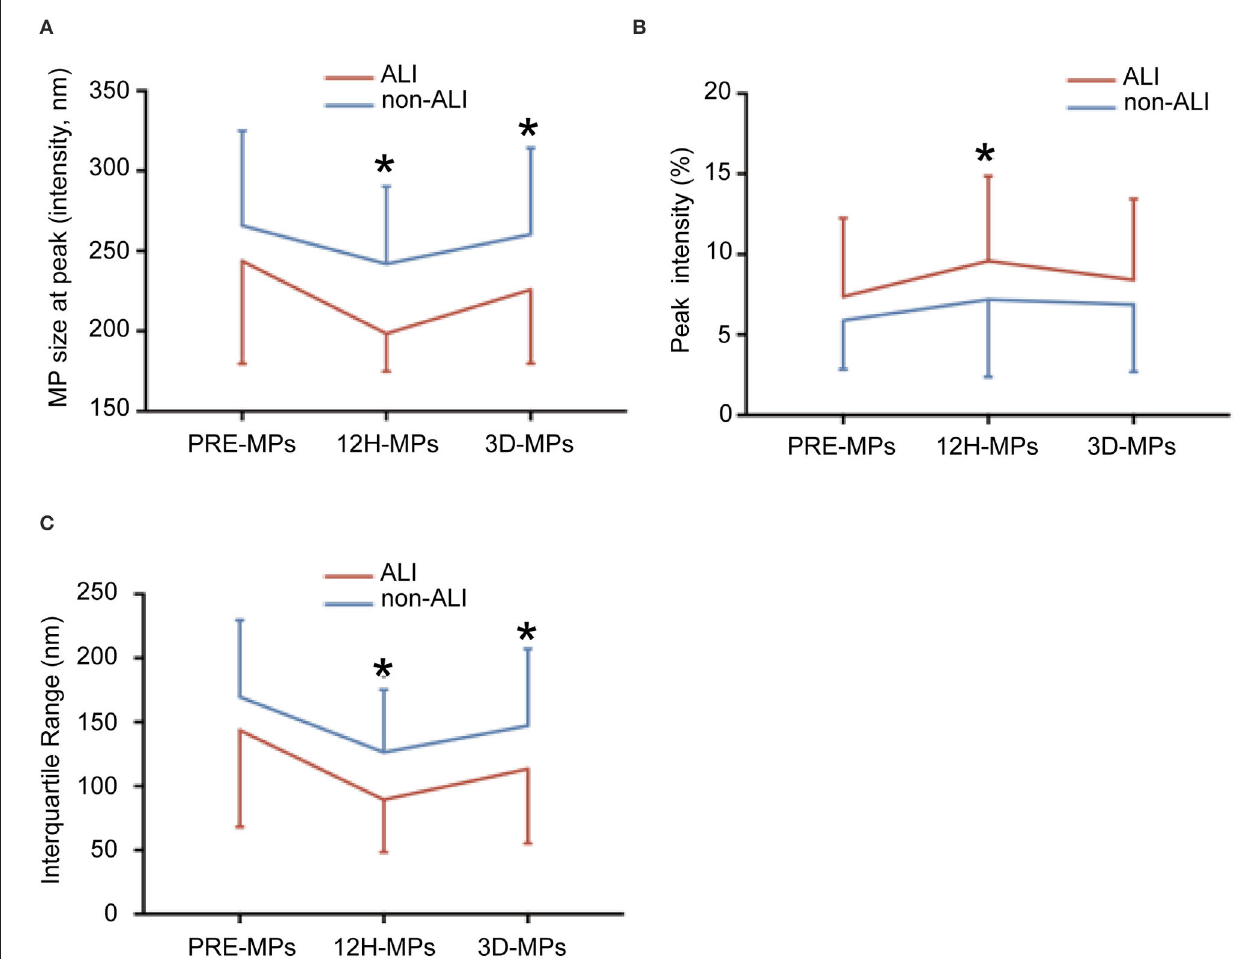
FIGURE 5 | The size distribution of microparticles (MPs) at different times between ALI and non-ALI groups. (A) The MPs size at peak between ALI and non-ALI groups. (B) The IQR between ALI and non-ALI groups. (C) The peak intensity between ALI and non-ALI groups. *, vs. ALI group at the same time point, P < 0.05. PRE-MPs, MPs from pre-operation; 12H-MPs, MPs from 12h after operation; 3D-MPs, MPs from 3 d after the